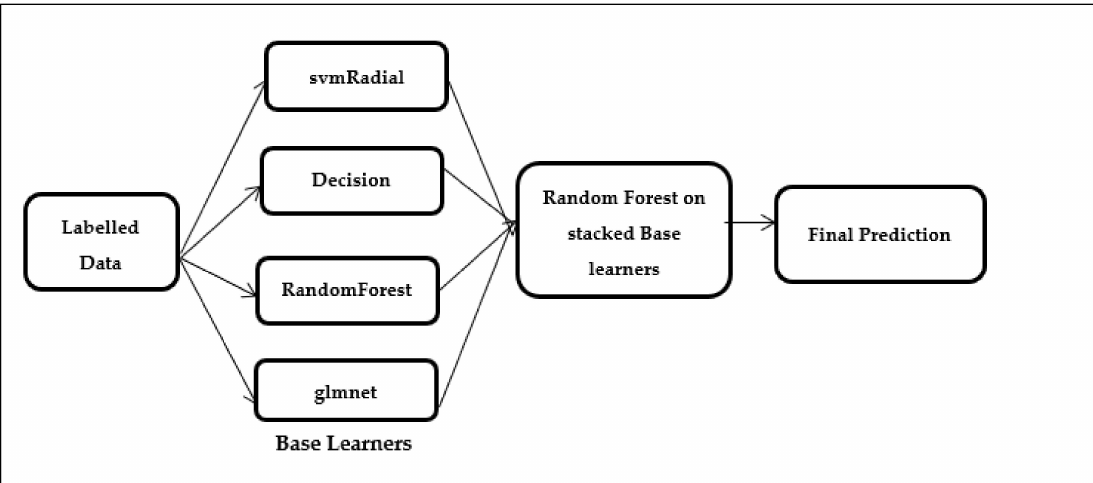
Figure 2. Stacked random forest